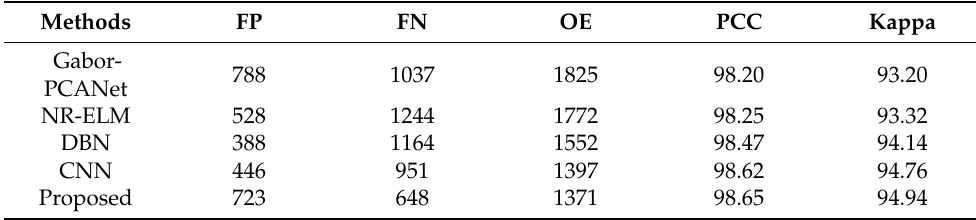
Figure 16. Change detection results on the Ottawa dataset. ( a ) Ground truth. ( b ) Result by Gabor- PCANet. ( c ) Result by NR-ELM. ( d ) Result by DBN. ( e ) Result by CNN. ( f ) Result by our pro- posed method. Table 3. Change detection results of the Ottawa